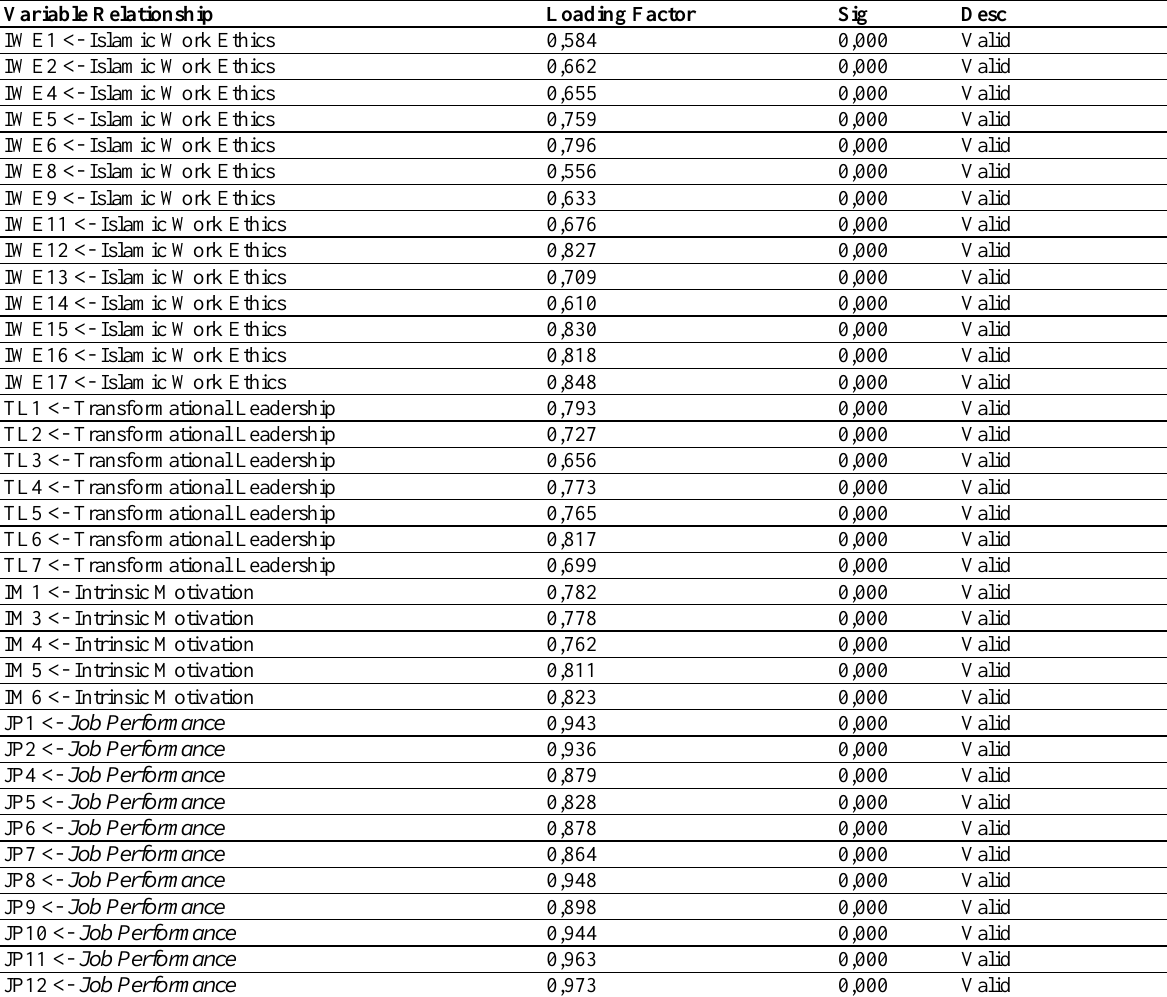
Figure 1: Convergent Validity Measurement Results; Source: Primary Data processed, 2022 Based on Figure 1, all loading factors are above 0,5. This means that all items measurement used in this study are valid, and it can be used for further analysis. The complete results are shown in Table 2. Table 2: Outer Loadings Indicator